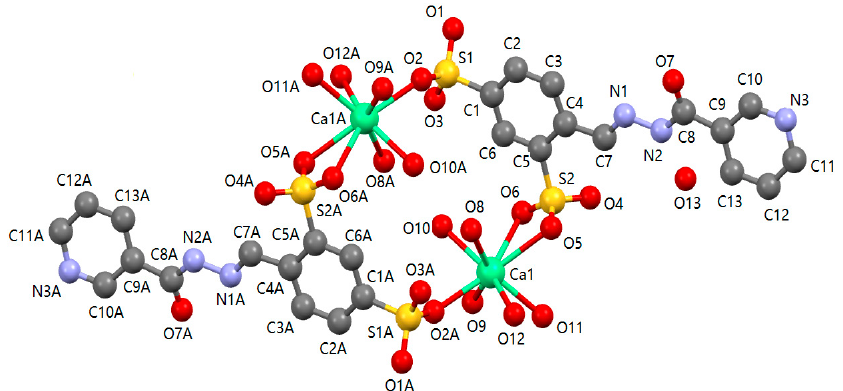
Figure 2. The coordination environment of 1 .